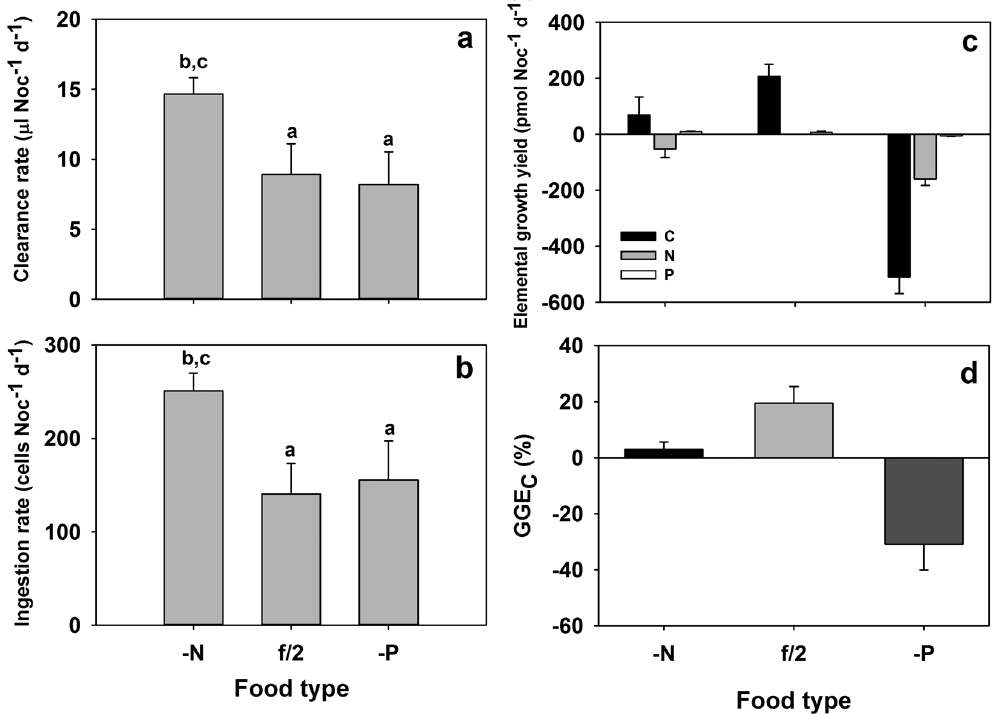
Figure 1. Clearance rate ( a ), ingestion rate ( b ), elemental growth yield ( c ) and gross growth efficiency ( d ) of Noctiluca scintillans on different quality Thalassiosira weissflogii [N-limited (-N), nutrient-balanced (f/2), P-limited (-P)]. Error bars = + 1 SD, n = 3. Superscript letters indicate significant differences between nutrient